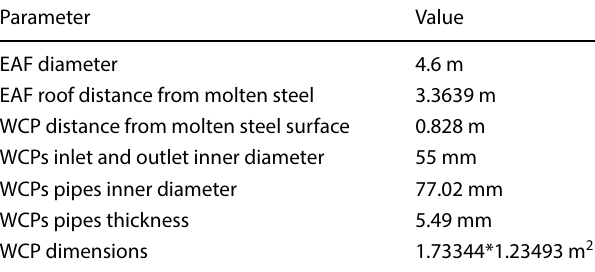
Table 4 Geometrical dimensions of EAF and